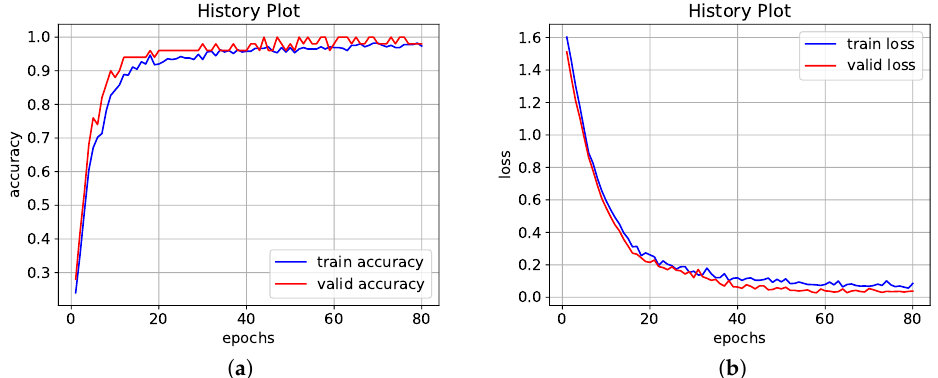
Figure 15. Example changes in model metrics during DNN classifier training/validation, ( a ) accuracy ( b )